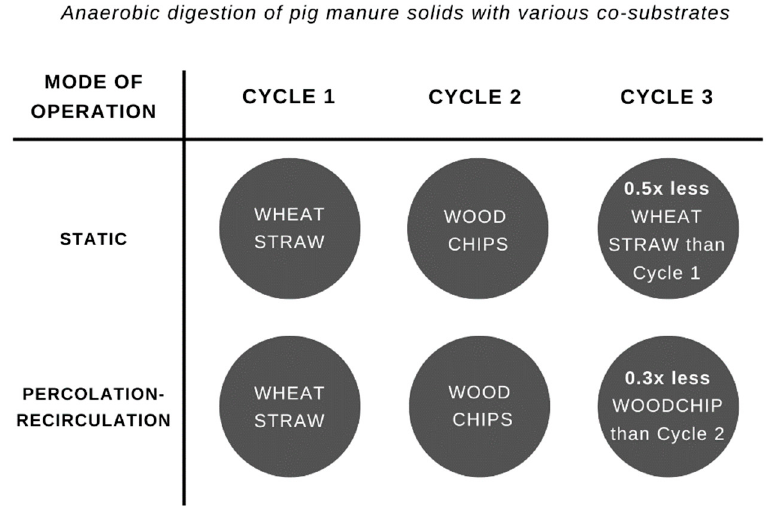
Figure 2. Visual representation of all experiments conducted.